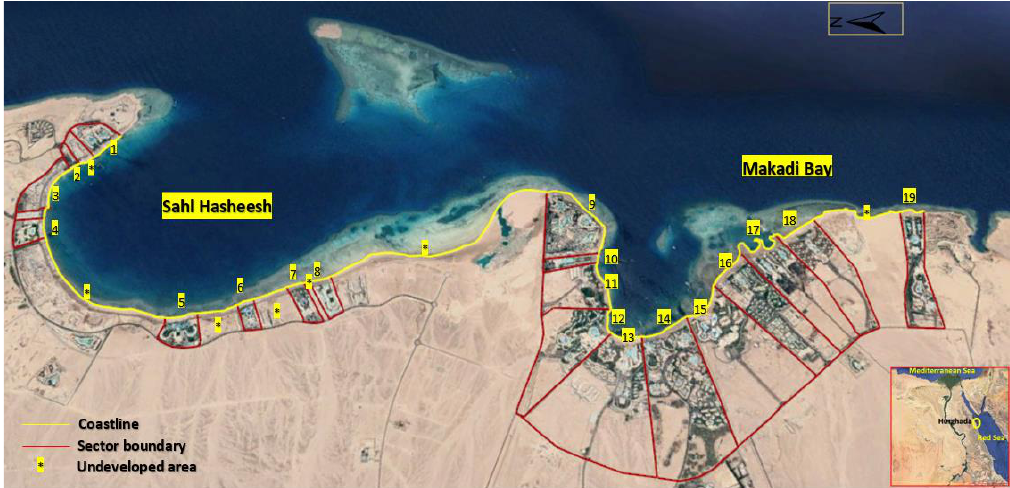
Figure 1. Satellite image of the study area (Sahl Hasheesh and Makadi Bay, Hurghada, Egypt). The tidal range of the Red Sea is semi-diurnal, with a maximum peak every 12 h and a mean tidal range of about 0.8 m, and the mean sea level shows seasonal variations that are about 0.5